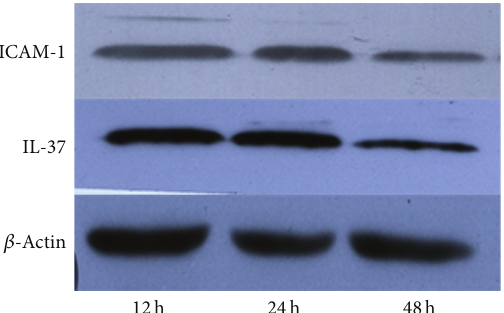
Figure 1: Leukocytic IL-37 and ICAM-1 expression change at early period. Leukocytic IL-37 and ICAM-1 protein expression were detected with immunoblotting. Both leukocytic IL-37 and ICAM- 1 protein were highest expressed at 12h point but significantly decreased at 48 h point ( 𝑃 < 0.05 , 𝑛 = 48